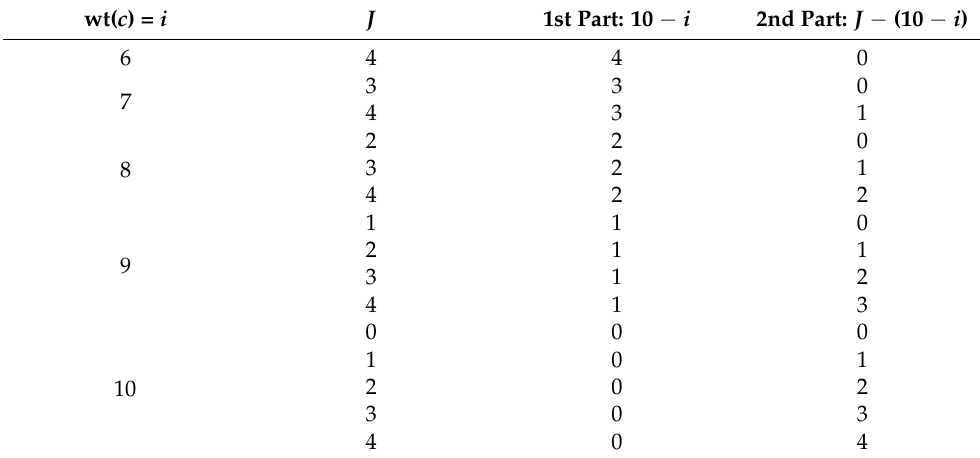
Table 4. Process of choosing J